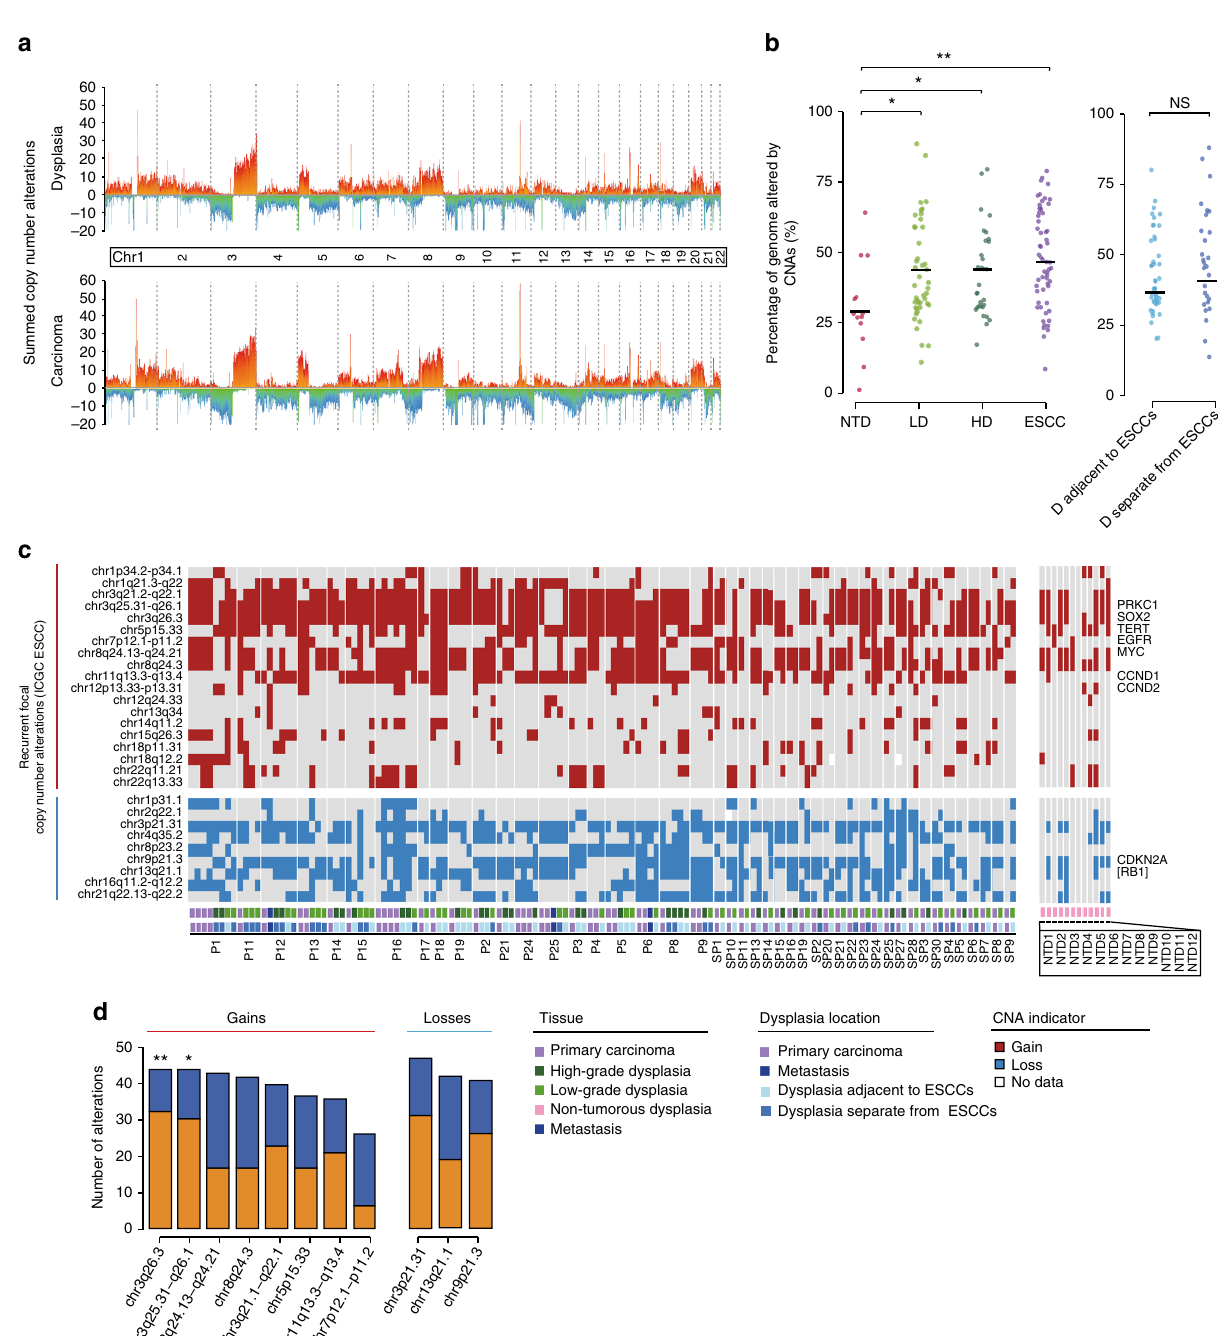
Fig. 4 Copy number alterations in dysplasia samples and ESCCs. a Stacked mountain plots displaying the summed copy number alterations for 33 dysplasia samples ( top ) and 33 ESCCs ( bottom ). For each 500-Kb window of the whole genome, the depth ratios of all samples are transformed with log 2 and summed. The copy number gains and losses are denoted by warm-color peaks and cool-color valleys, respectively. b Left , the fraction of genomic regions affected by CNAs in the four groups, NTDs, LDs, HDs, and ESCCs; right , the fraction of genomic regions affected by CNAs in the dysplasia adjacent to ESCCs and separate from ESCCs. The median value is indicated. Student ’ s t -test, * P < 0.05, ** P < 0.01, NS, not signi fi cant. c Heat maps showing the recurrent CNAs reported in ICGC. Potential driver genes encompassed by certain cytobands are shown at right, and the square brackets represent the genes located adjacent to the cytoband. The results in the sample NTD13 is not shown due to the non-available data in these focal regions. d Bar plots showing the number of CNA events that are shared by all samples ( orange ) or part of samples ( blue ) in patients. Fisher ’ s exact test, * P < 0.05, ** P < (33 carcinoma samples and 33 dysplasia samples). Upon Fig. 9), though such concordance was tilted to arm/chromosome examination of the whole genome, both dysplasia samples and level CNAs. To assess the CNAs more accurately, we also per- ESCCs showed extensive CNAs (Fig. 4a, Supplementary Fig. 8). formed CNA calling based on the exome sequencing data, taking Moreover, their copy number patterns displayed a high the purity and ploidy of each sample into account. The fractions resemblance (Pearson correlation, r = 0.96; Supplementary of the genome affected by CNAs in the LDs, HDs, and ESCCs